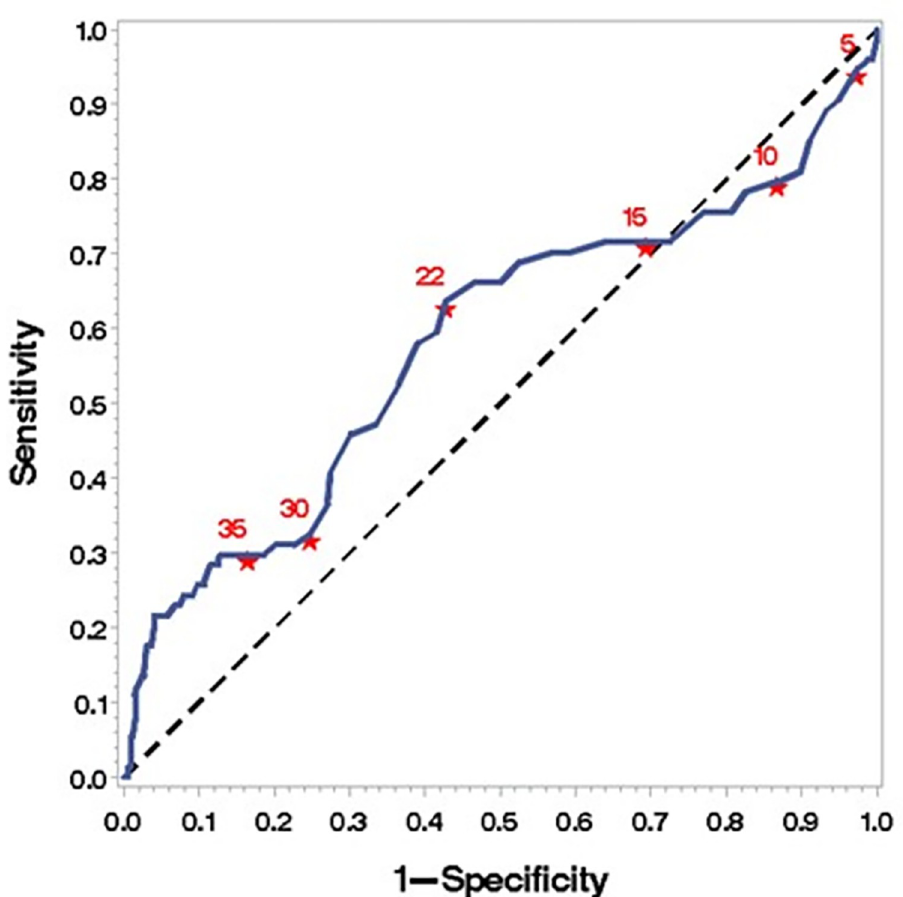
Fig 2. Cutoff point for mortality from the 22nd day of the total length of hospital stay. ROC (curve area 0.5816; 95% IC 0.4998–0.6634).